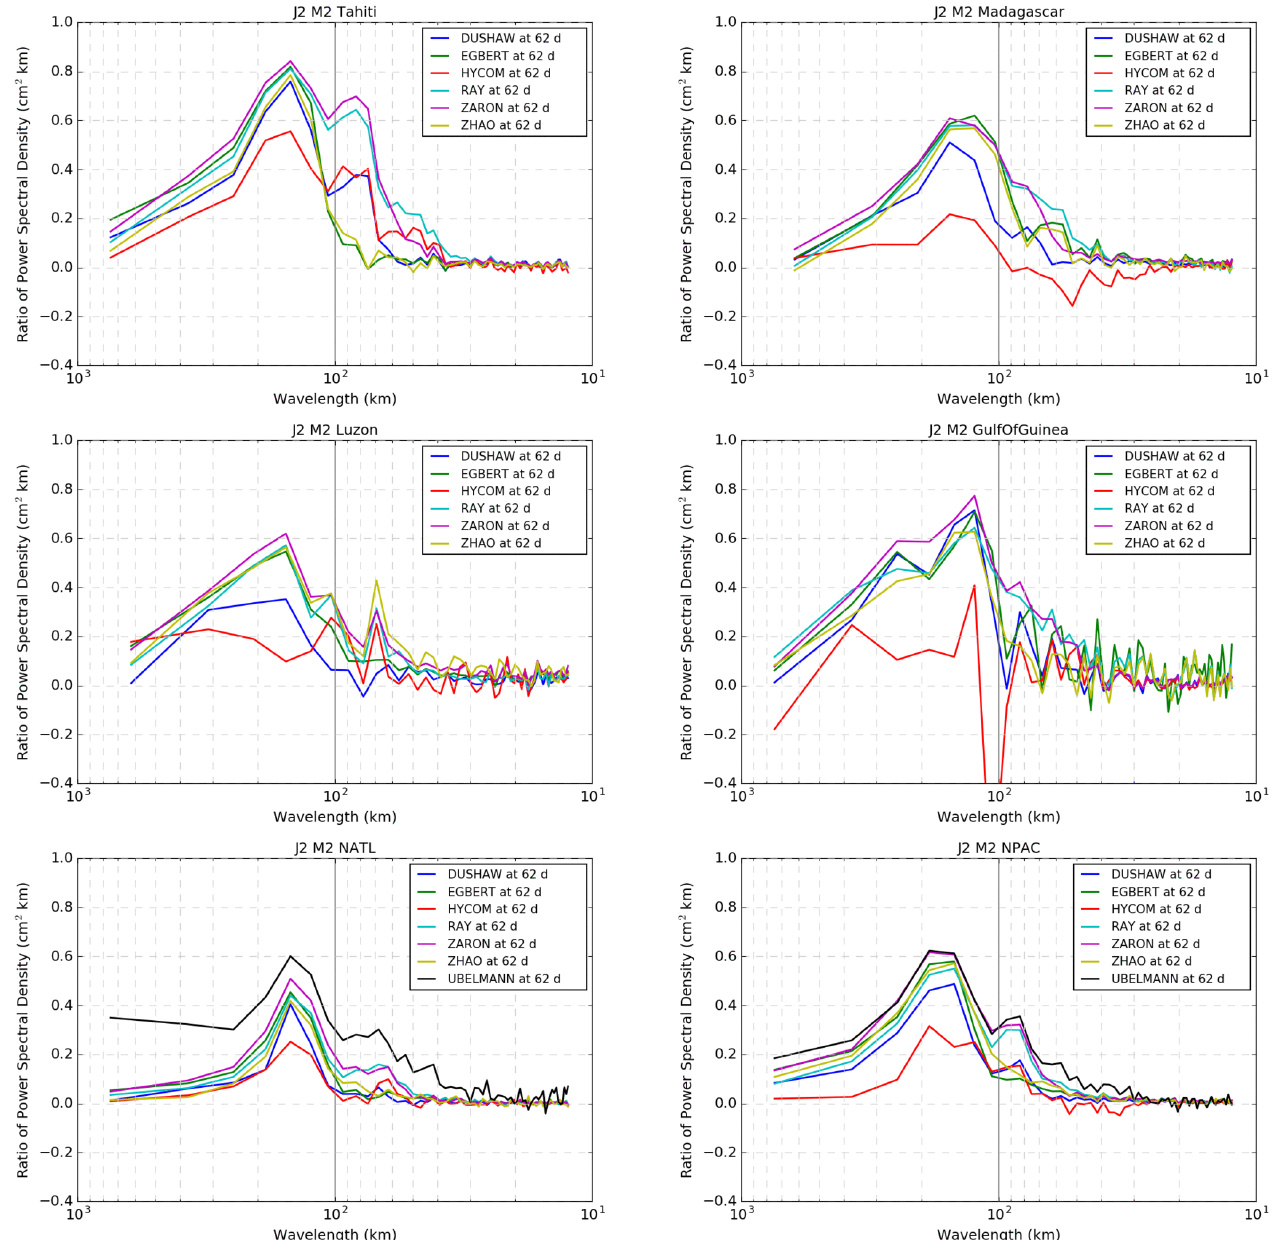
Figure 13. Normalized difference of the power spectral density of J2 SLA as a function of wavelength and for each IT region studied. Blue line – DUSHAW model; green – EGBERT model; red – HYCOM model; light blue – RAY model; purple – ZARON model; light green – ZHAO model; black – UBELMANN